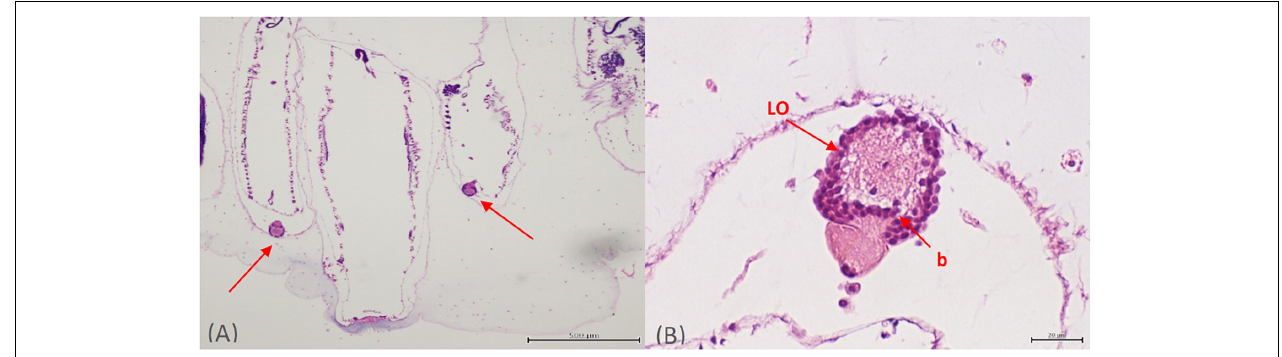
FIGURE 1 | Orientation of both light organs on either side of the buccal siphon (A) . Higher magnification of one individual light organ (LO) with bacteria (or more likely bacteriocytes) (B) .